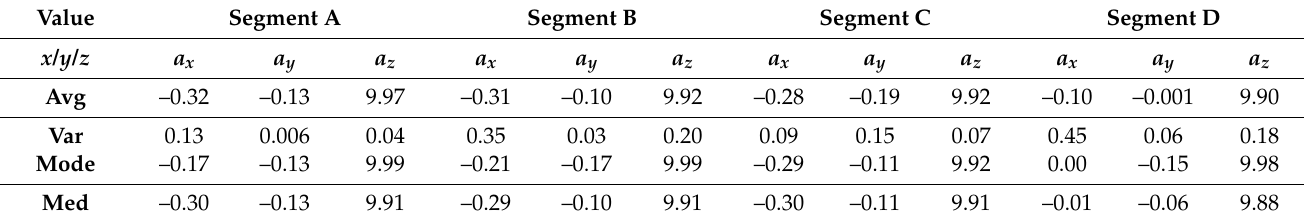
Table 3. Statistical characteristics of a data set of acceleration in the defined segments. Source: authors’ own elaboration.